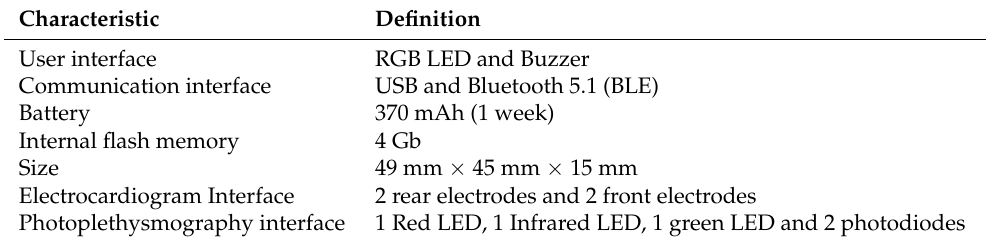
Table 2. Wearable’s technical specification.